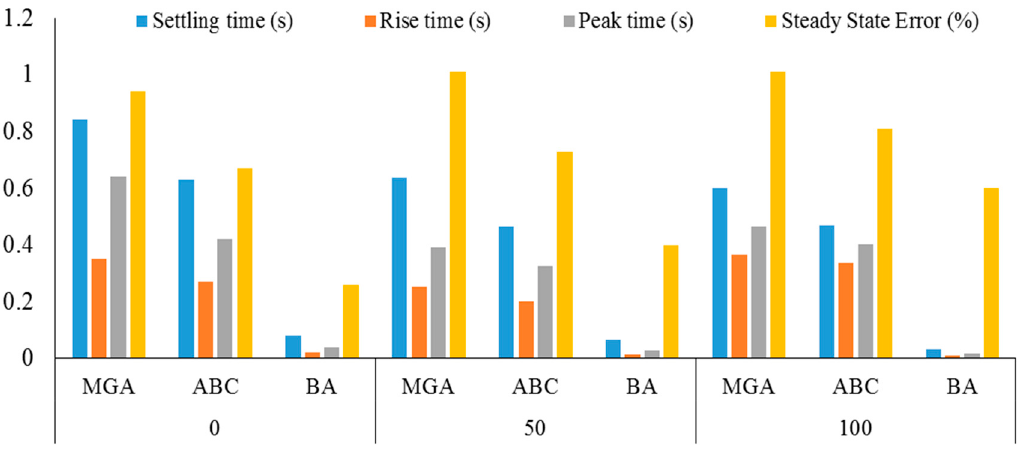
Figure 13. Results for the study by Vanchinathan (2018) [78].